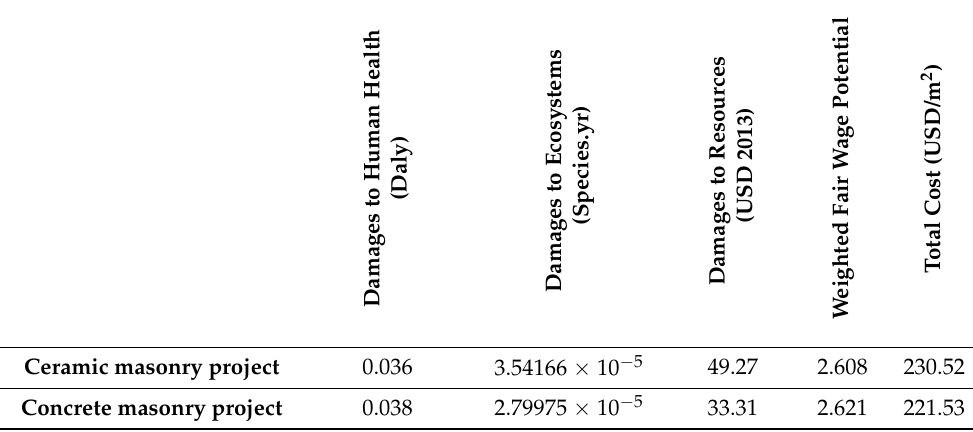
Table 11. Egalitarian perspective: values of the criteria for determining sustainability.